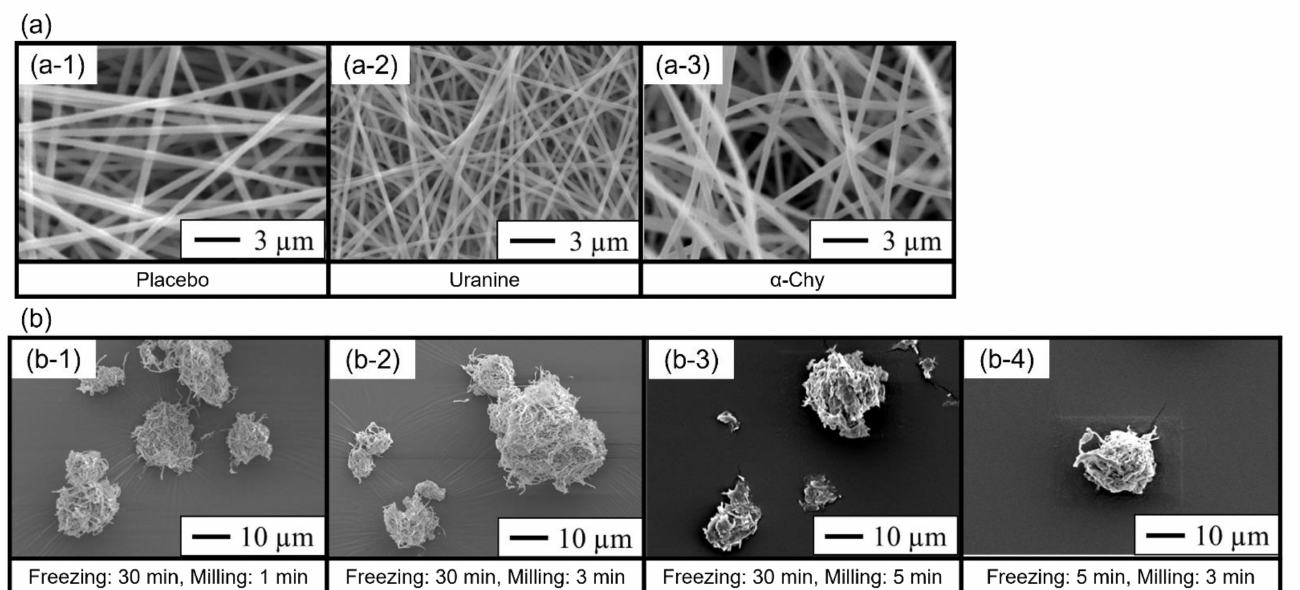
Figure 1. Scanning electron micrographs of the electrospun nanofiber mats and milled nanofiber mats. ( a ) Nanofiber mats prepared using the electrospinning technique. ( a-1 ) A polyvinyl alcohol (PVA) nanofiber mat without the experimental drugs, ( a-2 ) the PVA nanofiber mat loaded with uranine, and ( a-3 ) the PVA nanofiber mat loaded with α -chymotrypsin ( α -Chy). ( b ) Uranine-loaded PVA nanofiber mats milled by cryo-milling. ( b-1 ) freezing: 30 min, milling: 1 min; ( b-2 ) freezing: 30 min, milling: 3 min; ( b-3 ) freezing: 30 min, milling: 5 min; and ( b-4 ) freezing: 5 min, milling: 3 min.